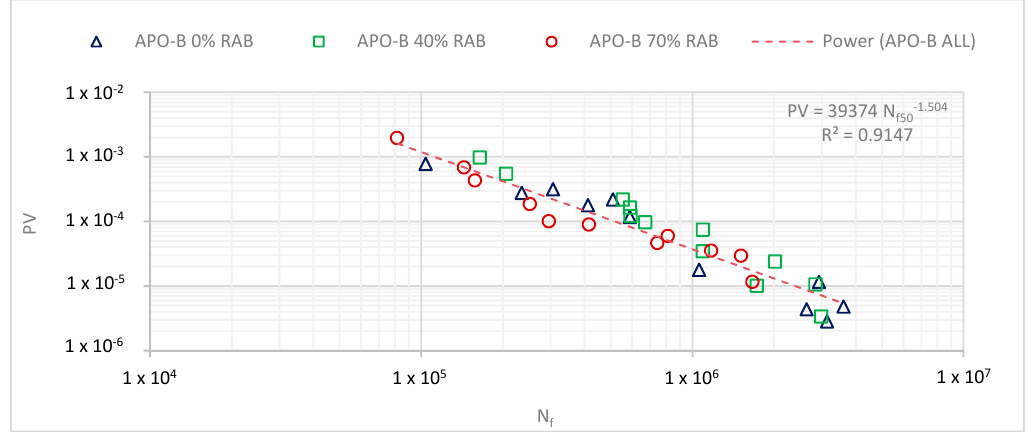
Figure 6. Unified fatigue model for all three mixtures, based on the plateau value (PV) and the loading cycles to failure (N f ).